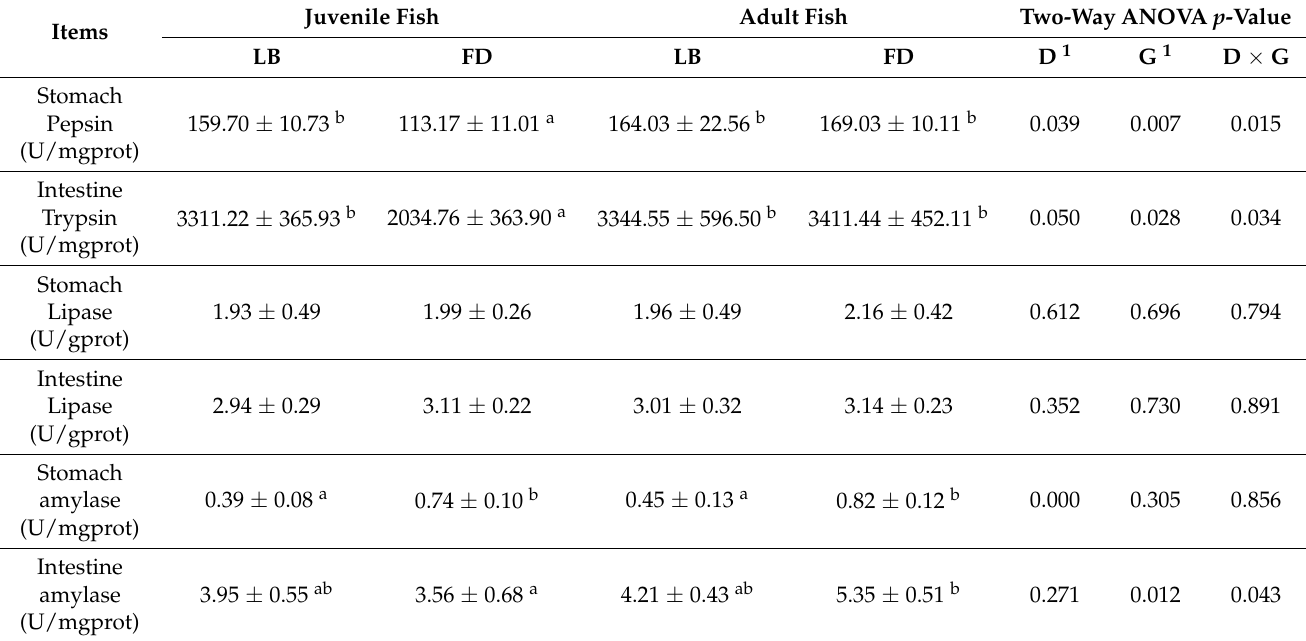
Table 8. Effects of live baits and formulated diet on the digestive enzyme activities of Siniperca chuatsi at different growth stages 1